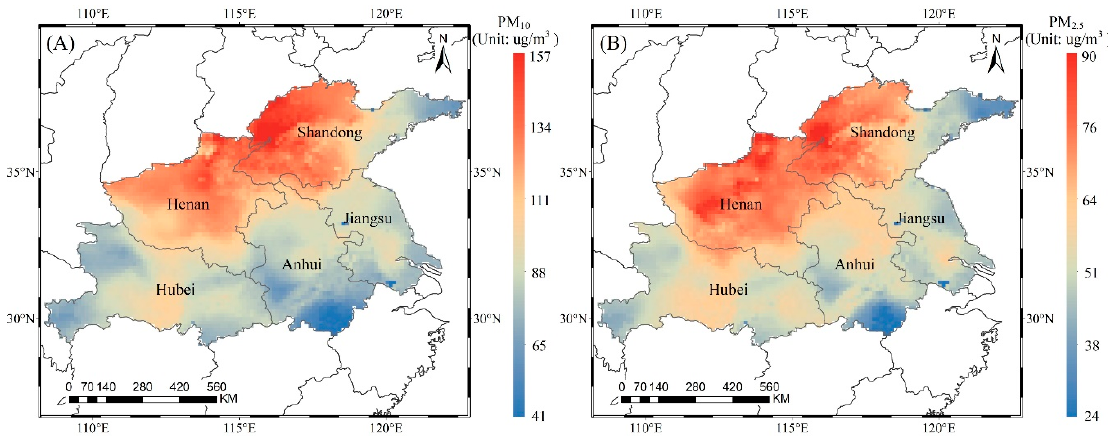
Figure 4. Spatial distribution of ground-level PM 10 ( A ) and PM 2.5 ( B ) in 2016.